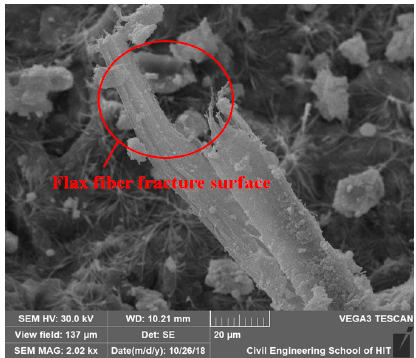
Figure 10. SEM image of a flax fiber fracture surface at about 2000 × .